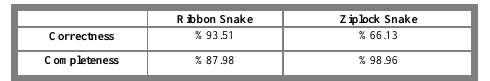
Table 9: The results of extraction of non-salient roads